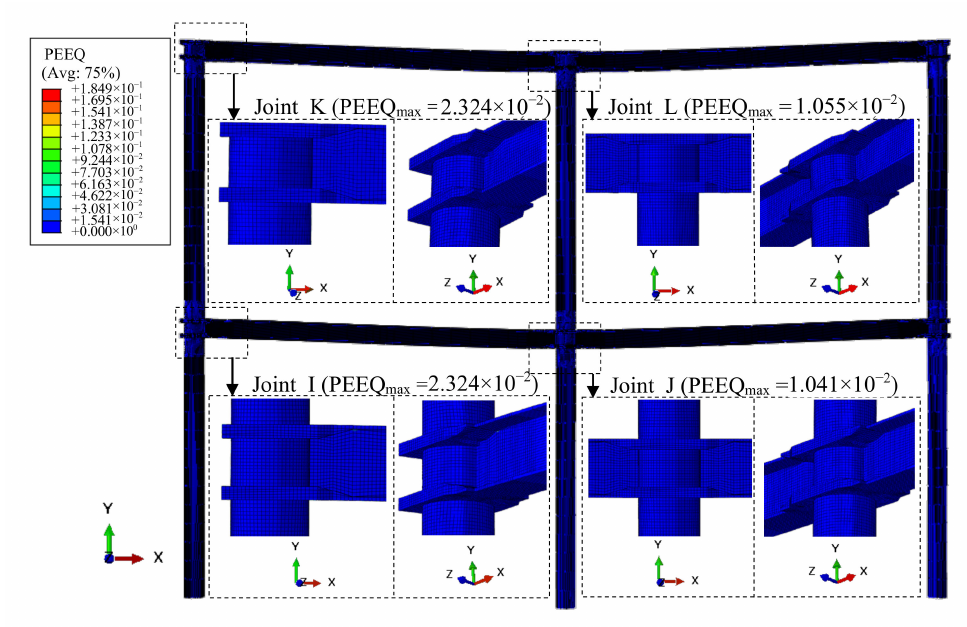
Figure 8. Equivalent plastic strain of model B c when the vertical displacement of the interior column reached its maximum value under load (iii).